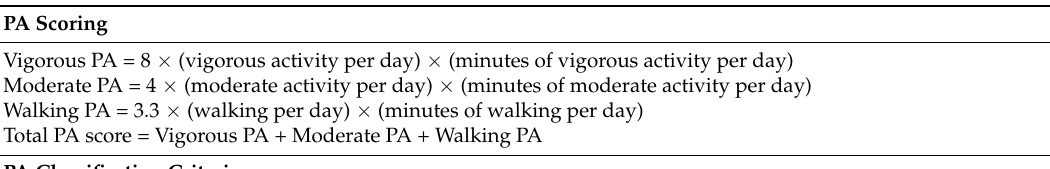
Table 1. International physical activity questionnaire (IPAQ) scoring guidelines and physical activity (PA) classification